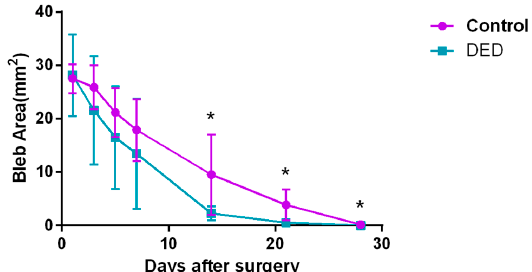
Figure 6. Changes in filtering bleb area over 28 days in the two groups. The filtering bleb areas shrank slowly with time in both groups. On days 14, 21 and 28 after surgery, the DED group displayed significantly smaller blebs than the control group. There were no significant differences in the bleb areas between the two groups on days 1, 3, 5 and 7 post-surgery. * p < 0.05.